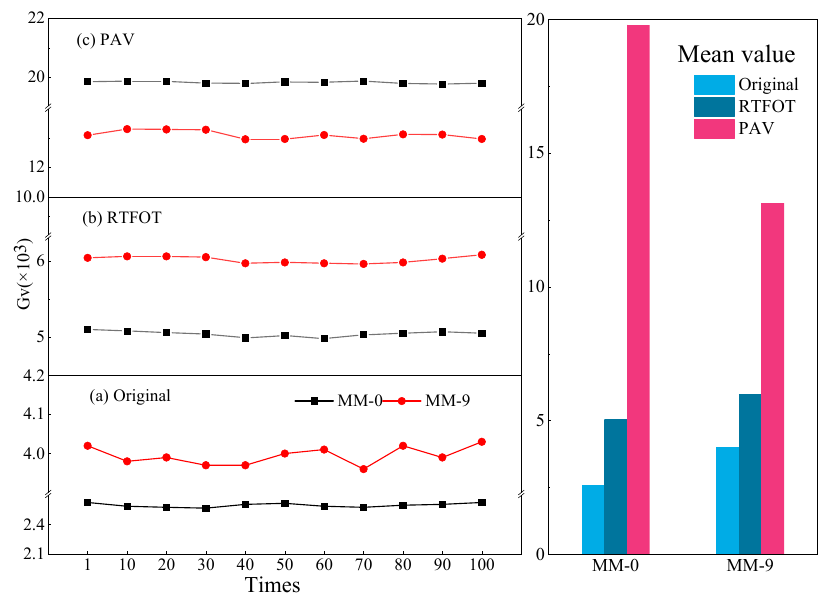
Figure 6. The viscous component G v of the Maoming 70# binder and the lignin ‐ modified binder. ( a – c ) creep test viscosity component representing as is, short ‐ term aging and long ‐ term aging.